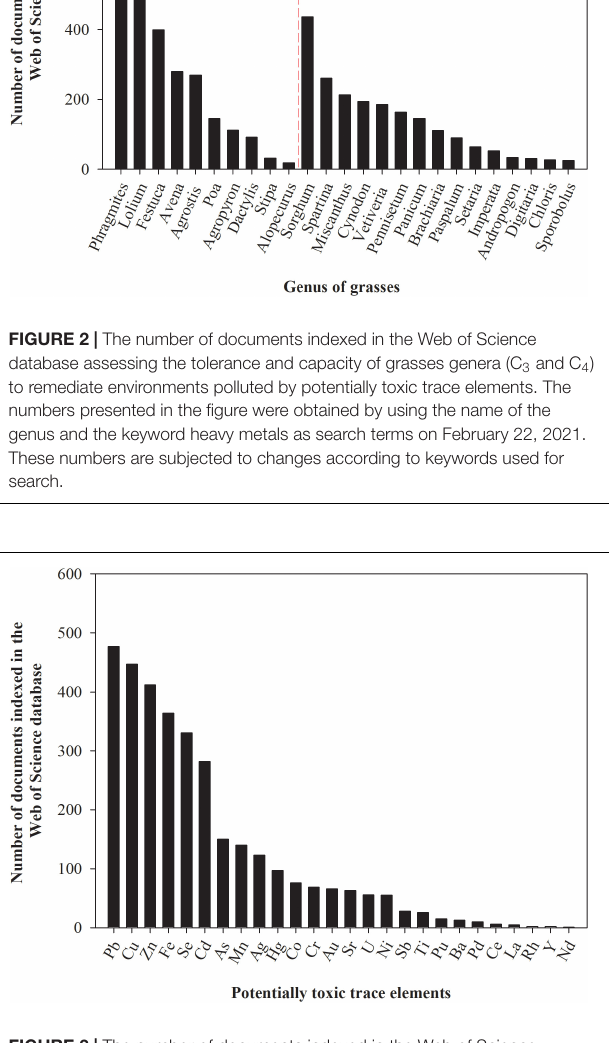
FIGURE 3 | The number of documents indexed in the Web of Science database assessing the effect of potentially toxic trace elements on tolerance, survival, and/or remediation capacity of grasses. The numbers presented in the figure were obtained by using the name of the potentially toxic trace element and the keyword grass as search terms on February 23, 2021. These numbers are subjected to changes according to keywords used for